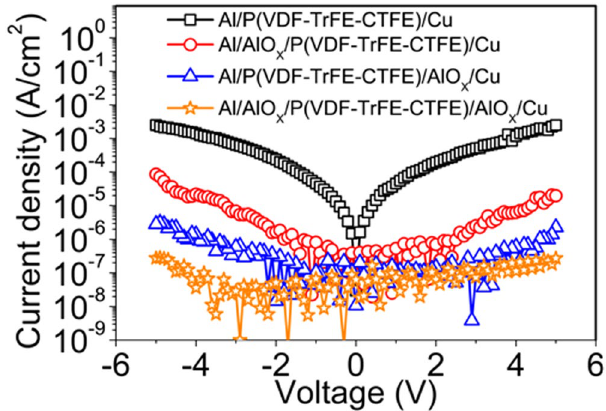
Figure 3. The leakage current density versus voltage of the capacitors with/without ultrathin AlO X layers at each side of the 60 nm thick P(VDF-TrFE-CTFE)